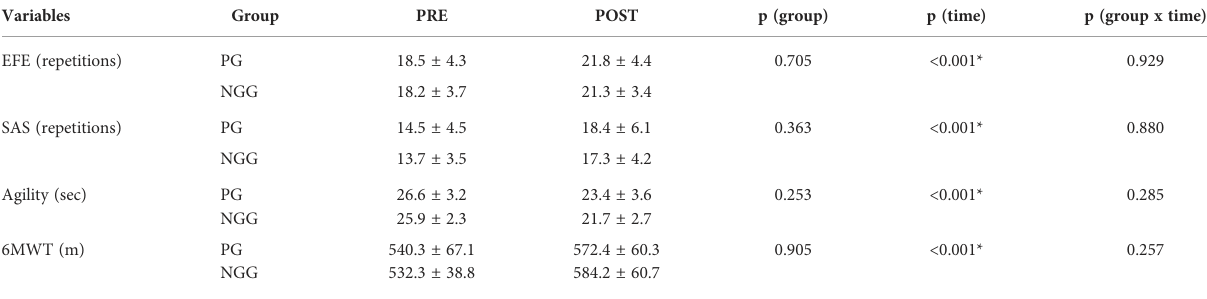
TABLE 2 Mean ± standard deviation of the PRE AND POST motor variables 14 weeks of combined training (PG: n 24; NGG: n 24). Variables Group PRE POST p (group) p (time) p (group x